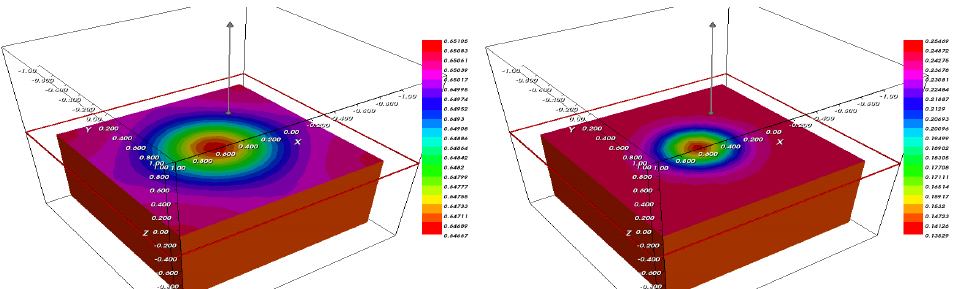
Figure 16. The fraction ϕ ( left ) and ψ ( right ) after T = 15.